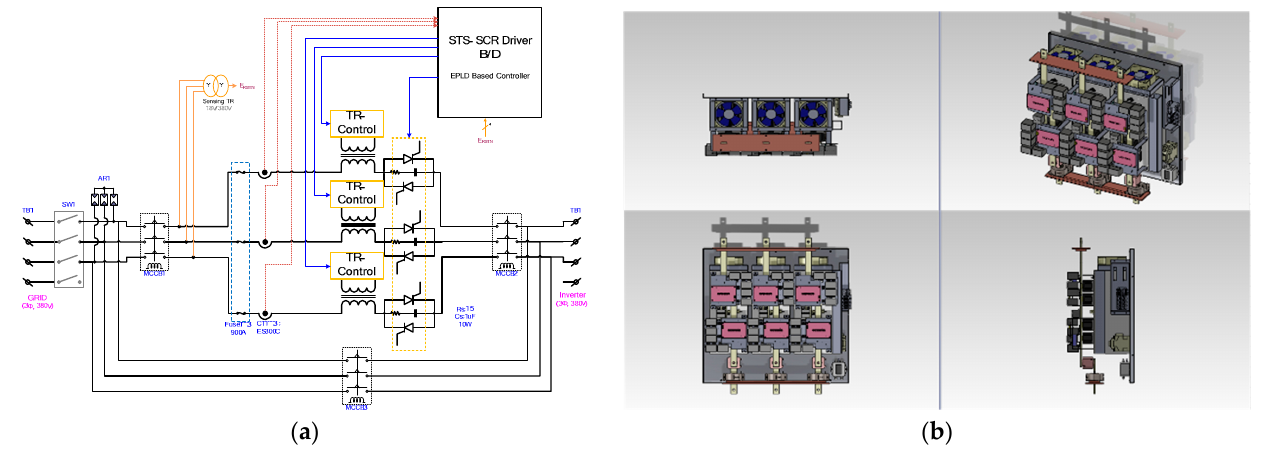
Figure 4. ( a ) Diagram of the static transfer switch; ( b ) the internal configuration of the static transfer switch.